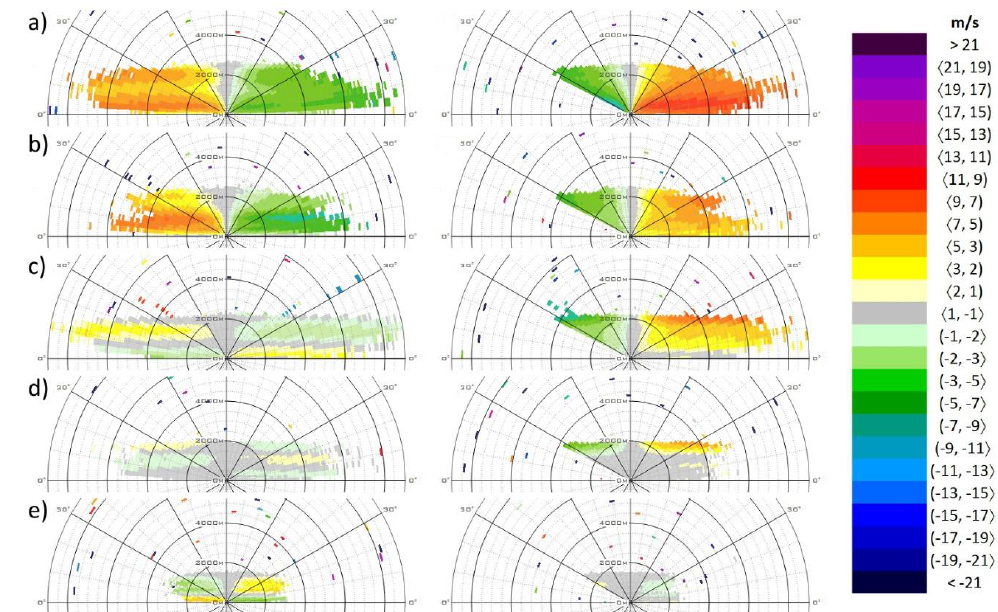
Figure 12. Vertical cross-sections obtained by the RHI scanning regime of lidar. Left column: RHI scans in the orientation of 40 ◦ and 220 ◦ . Right column: RHI scans in the orientation of 130 ◦ and 310 ◦ . ( a ) 19 September 2019, 20:17 UTC; ( b ) 20 September 2019, 02:17 UTC; ( c ) 20 September 2019, 20:23 UTC; ( d ) 21 September 2019, 02:15 UTC; ( e ) 21 September 2019, 06:20 UTC. Wind blowing towards the